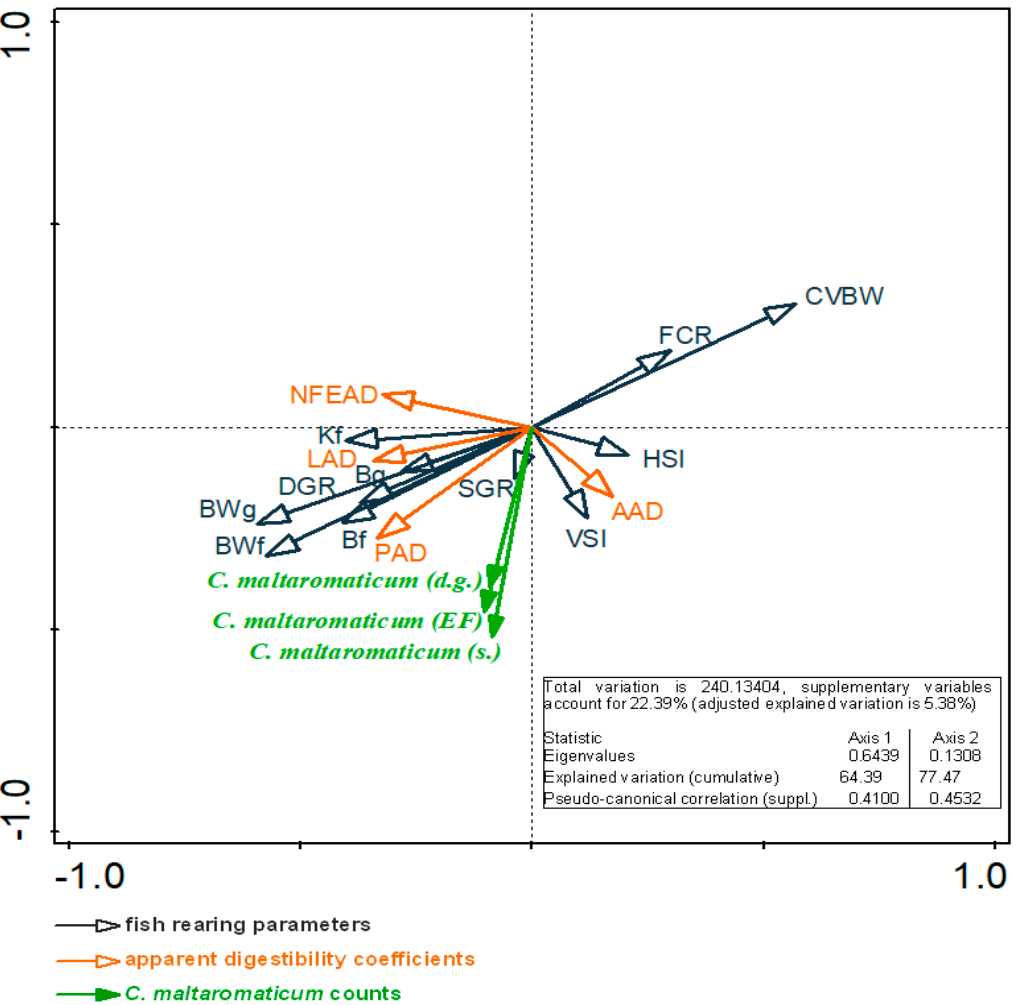
Figure 3. Principal component analysis (PCA) biplot of the correlations ( p < 0.05) between C. maltaromaticum counts in the digestive tract (d.g.) and skin (s.) of juvenile rainbow trout vs. the experimental feed (Aller Gold supplemented with 0.1% of the Carnobacterium maltaromaticum environmental probiotic strain), rearing parameters (BW g —body weight gain, BW f —final body weight, B f —final biomass, B g —biomass gain, SGR—specific growth rate, K f —final condition factor, FCR—feed conversion ratio, HIS—hepatosomatic index), and the apparent digestibility coefficients of crude protein (PAD), crude fat (LAD), crude ash (AAD), and nitrogen-free extract (NFEAD).